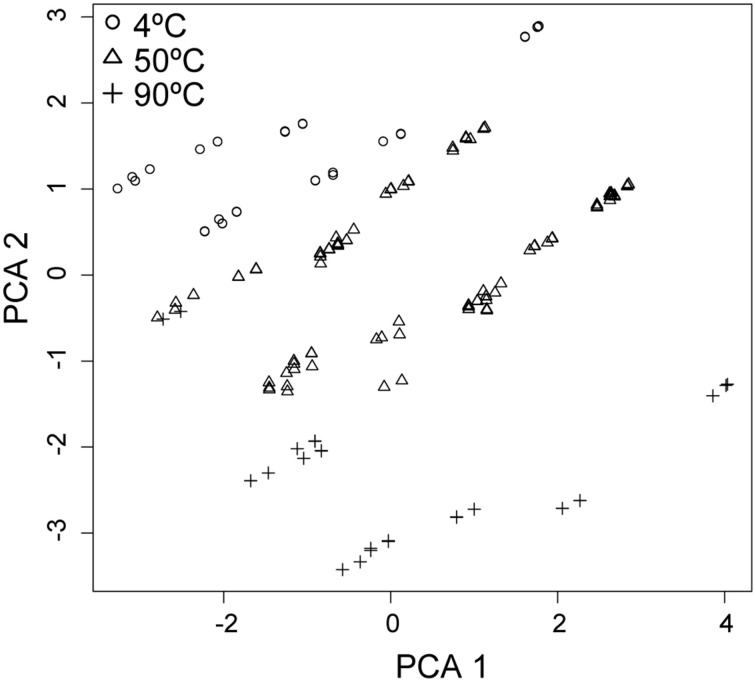
Principal component analysis (PCA) of the variation between samples (n = 274) as a linear combination of standardized chemical (sulfate, sulfide, pH, DOC, Cu2+, Fe2+, and Zn2+), thermal, rate and energetic parameters (variance within each parameter = 1). PCA 1 represents 28.5% and PCA 2 represents 19.9% of the variance within the data (PCA 3 and PCA 4, not shown, represent 12 and 10% respectively). Data are clustered most obviously by temperature at 4°C (○), 50°C (Δ), and 90°C (+).